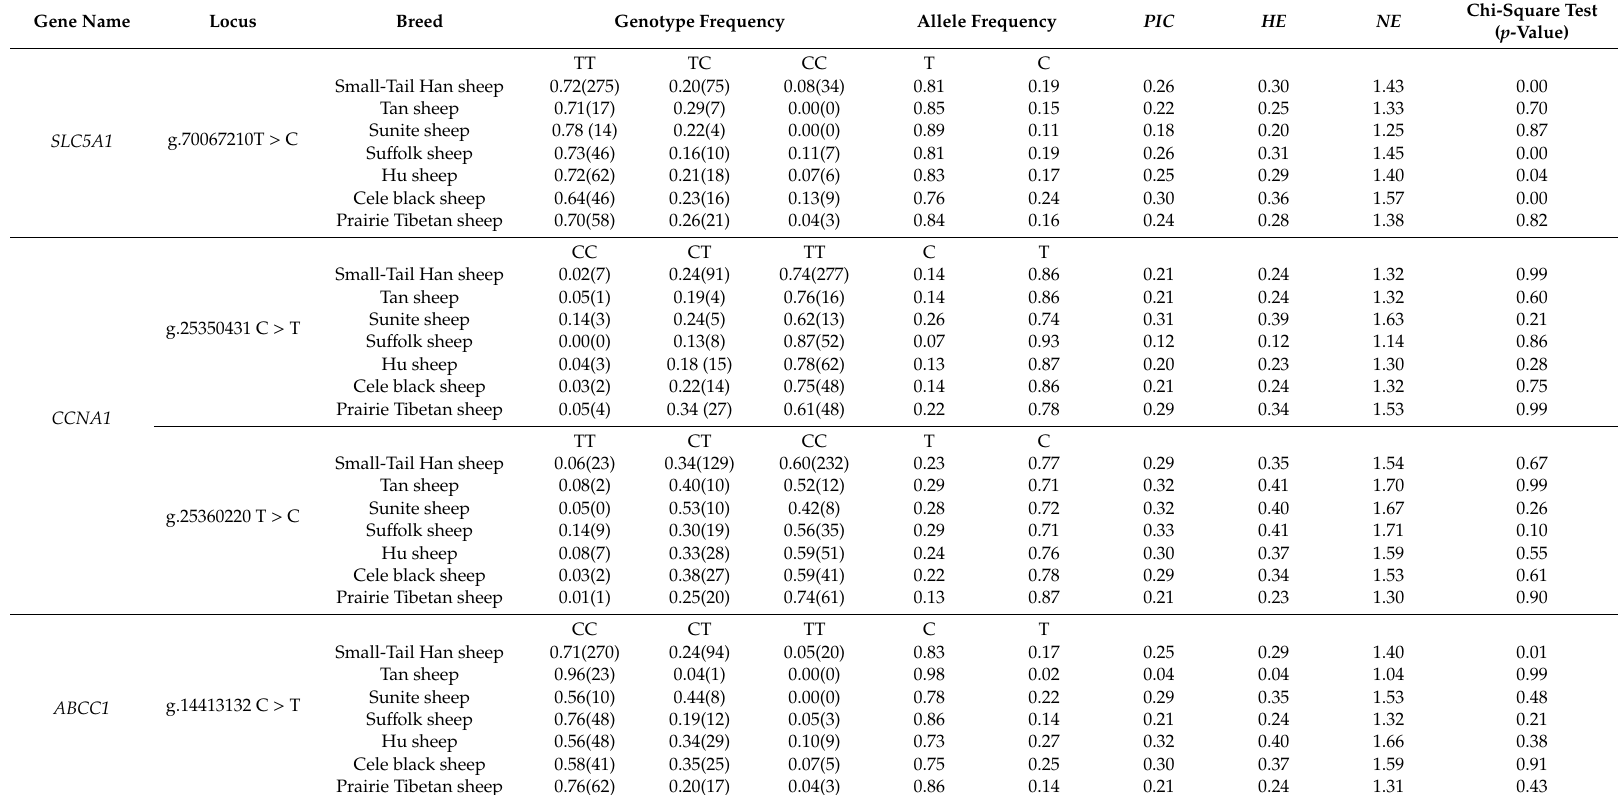
Table 2. Population genetic analysis of all loci in seven sheep